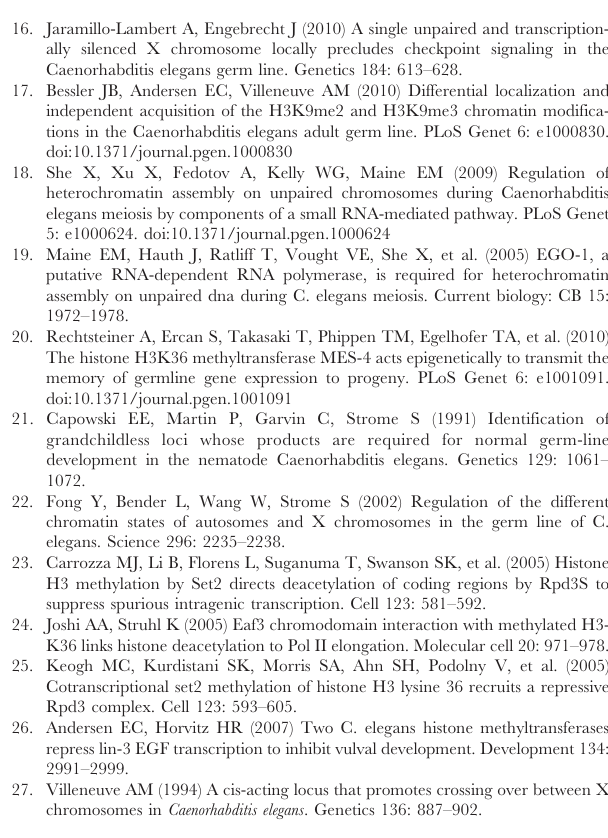
Figure S1 H3K9me2 can be observed adjacent to HIM-8 on unsynapsed X chromosomes. Indirect immunofluorescence was performed on meiotic nuclei in meDf2 heterozygotes using antibodies against the X chromosome PC protein HIM-8 and H3K9me2. Color and gray scale images (A–D) of two meiotic nuclei with unsynapsed X chromosomes (see Figure 2B). The nucleus on the left exhibits H3K9me2 enrichment adjacent to a HIM-8 signal, as outlined. Scale bar represents 4 microns. Figure S2 mnDp3 is often synapsed when it undergoes heterochromatin assembly. Indirect immunofluorescence was performed on meiotic nuclei in hermaphrodites carrying mnDp3 using antibodies against the SC component SYP-1 (A and C) and H3K9me2 (A and B). Arrows indicate meiotic nuclei in which the duplication is the primary H3K9me2 signal in the nucleus and load SYP-1. This was observed in 37 of 60 (62%) meiotic nuclei in which a primary H3K9me2 signal indicated the presence of a duplication.